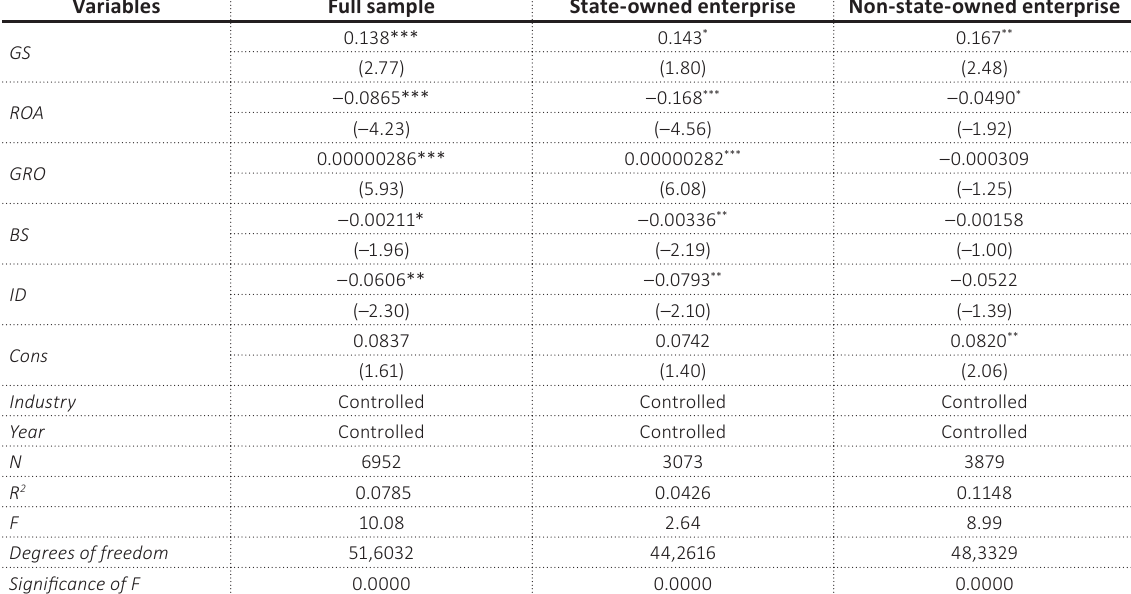
Table 4. Regression for Model